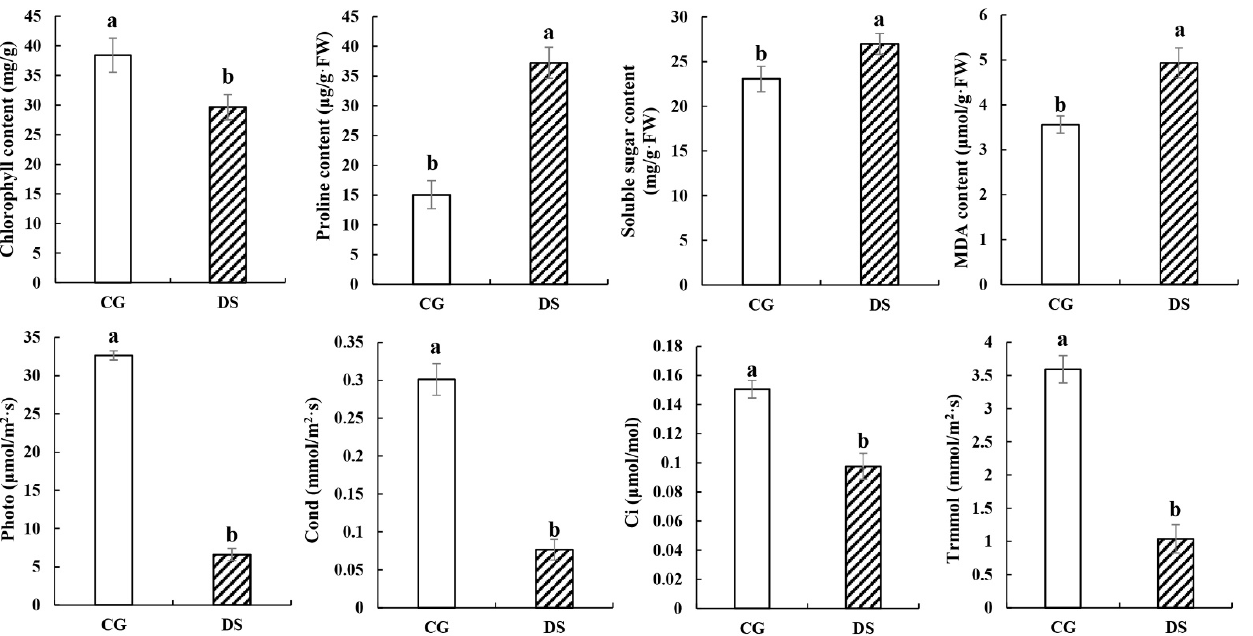
Figure 2. Physiological and biochemical indexes. Photo, Cond, Ci and Trmmol indicate net photo- synthesis, stomatal conductance, intercellular carbon dioxide concentration and transpiration rate, respectively. Error bars represent standard deviation among means for three different samples. Dif- ferent letters on bars indicate statistically significant differences between treatments ( p < 0.05).